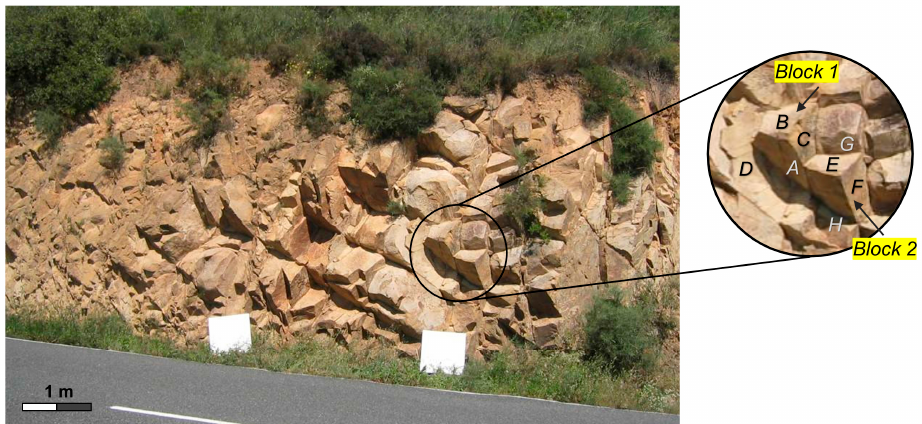
Figure 1. The surveyed rock exposure of Site 1 [43]. A partial magnification of two blocks is demonstrated, and some interrelated discontinuities are marked. The two white boards are 60 by 60 cm in dimension, and act as supplementary scale and orientation reference markers during the analysis of the laser scanned point cloud data. View direction is towards the East.